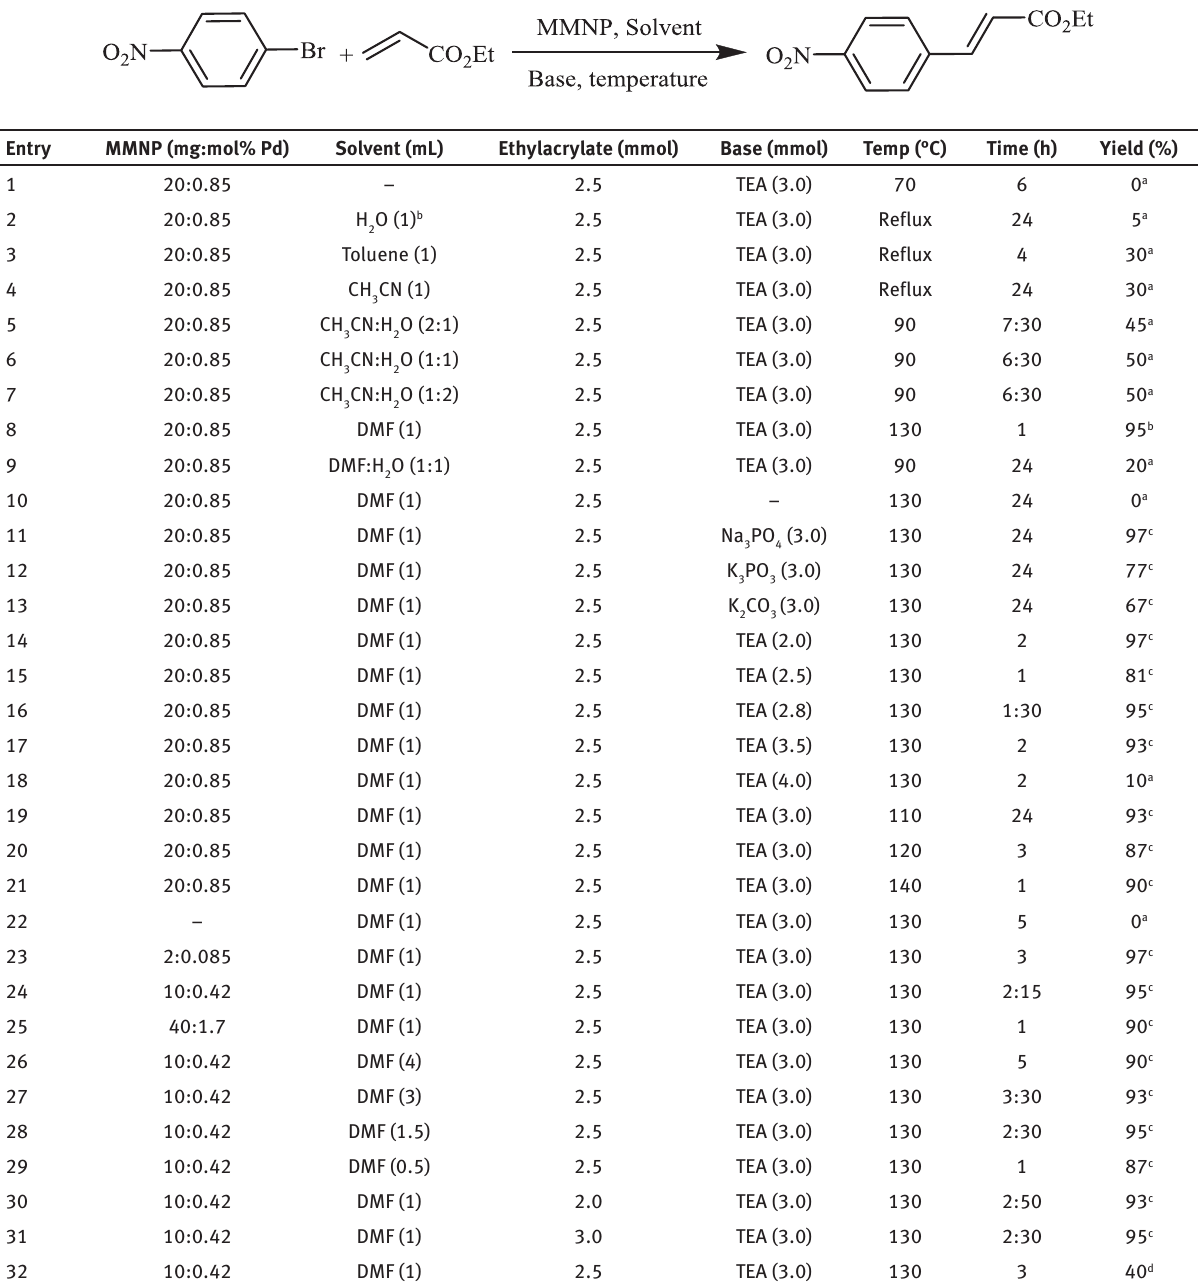
Table 4: Screening of various parameters for the Heck